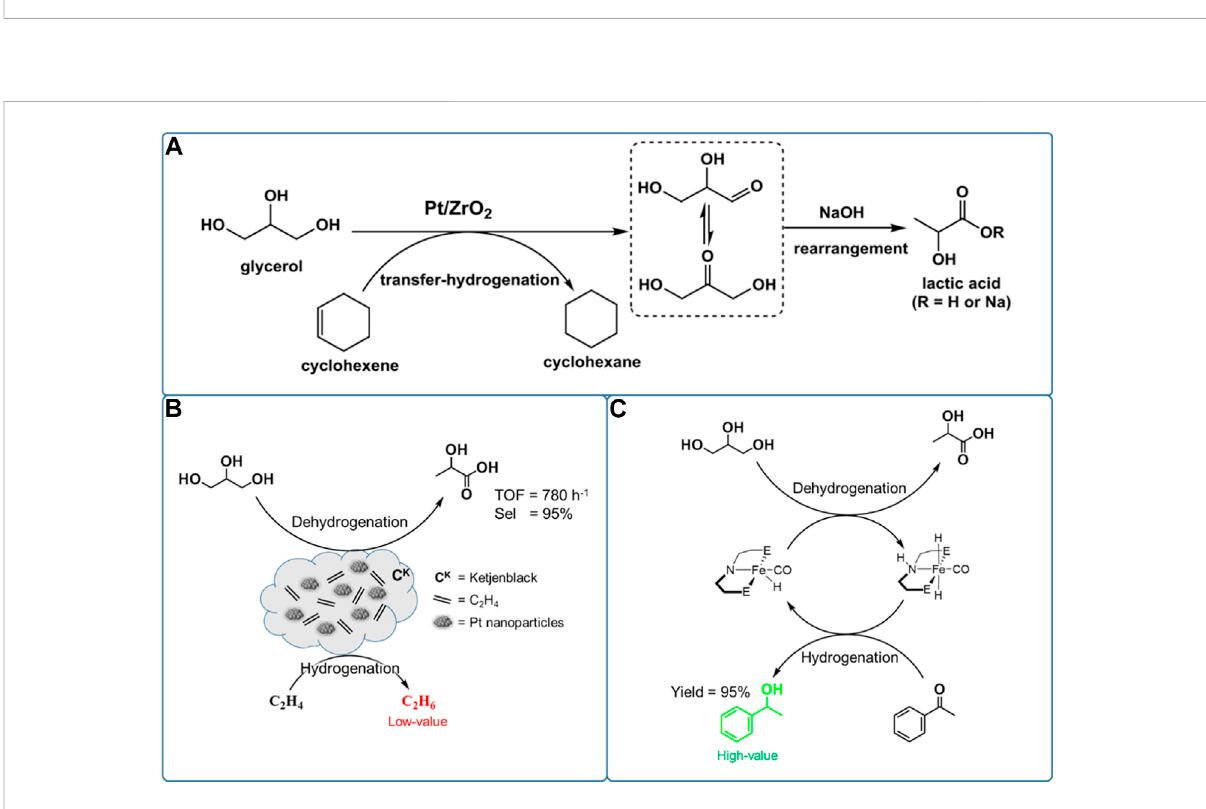
FIGURE 4 Dehydrogenation and catalytic transfer hydrogenation of glycerol and H 2